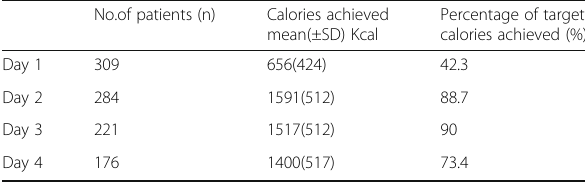
Table 29 (abstract A55). Calories achieved over days No.of patients (n)